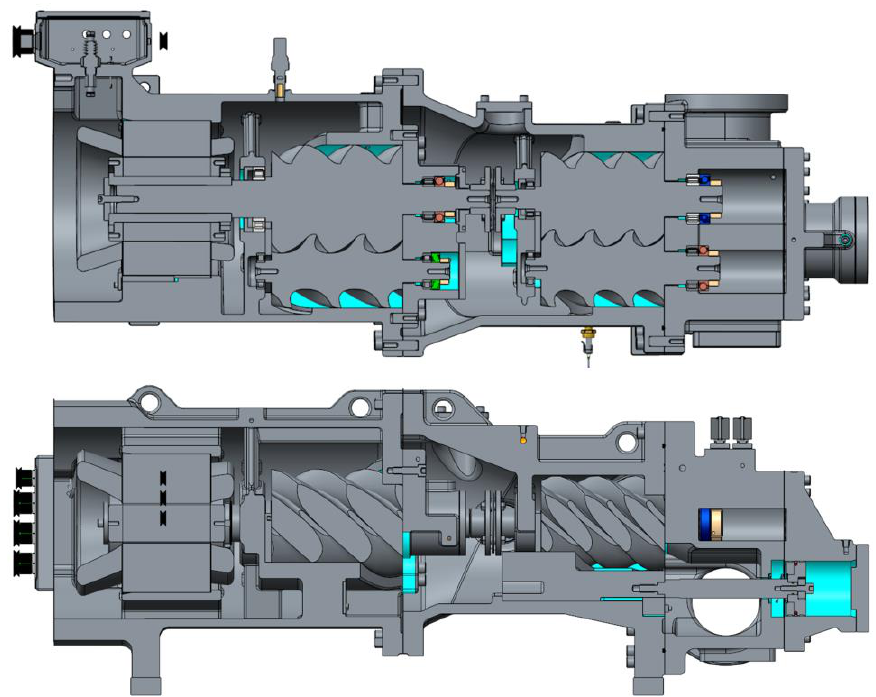
Figure 6. Three-dimensional model of the newly-designed two-stage refrigeration compressor.